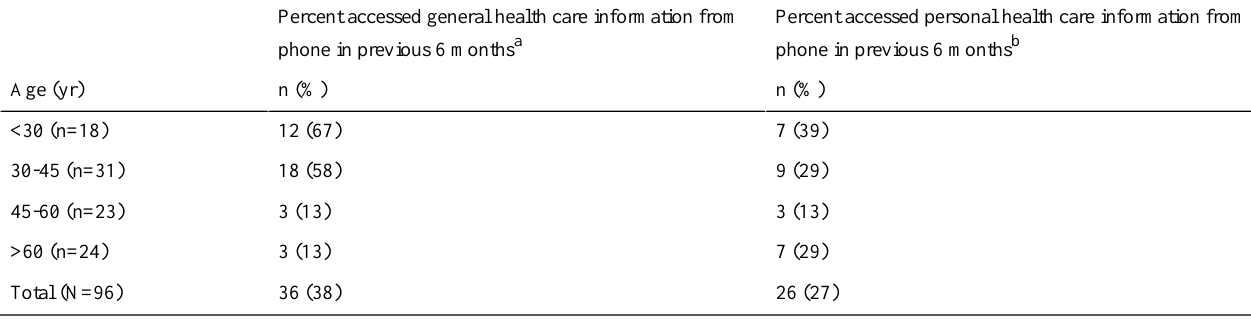
Table 4. Use of smartphone to access health care information (N=96).